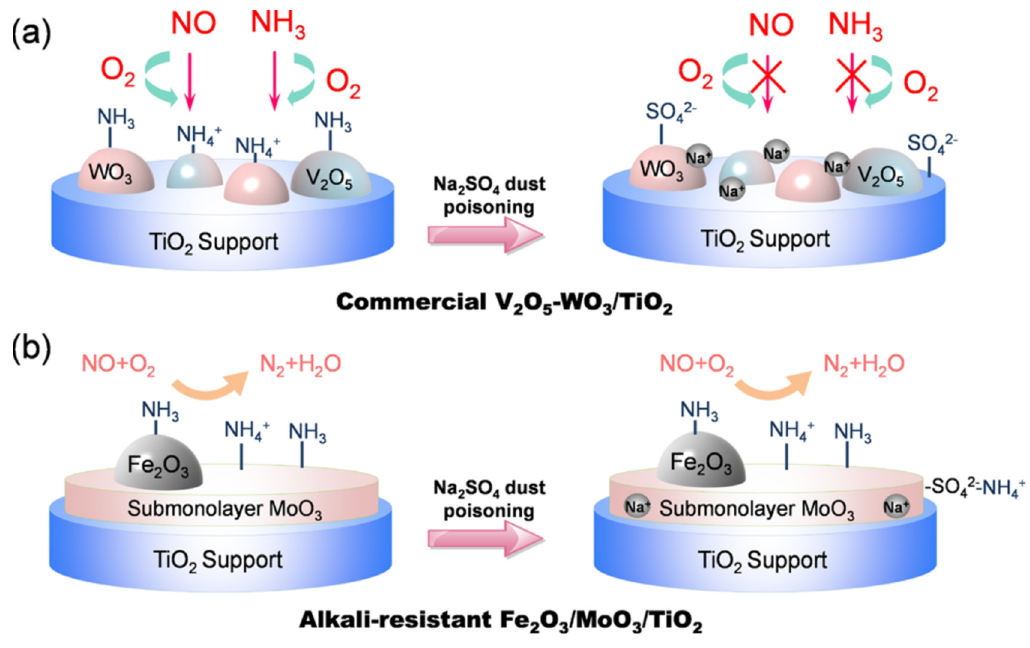
/ TiO 2 O 5 -WO 3 2 catalyst showing